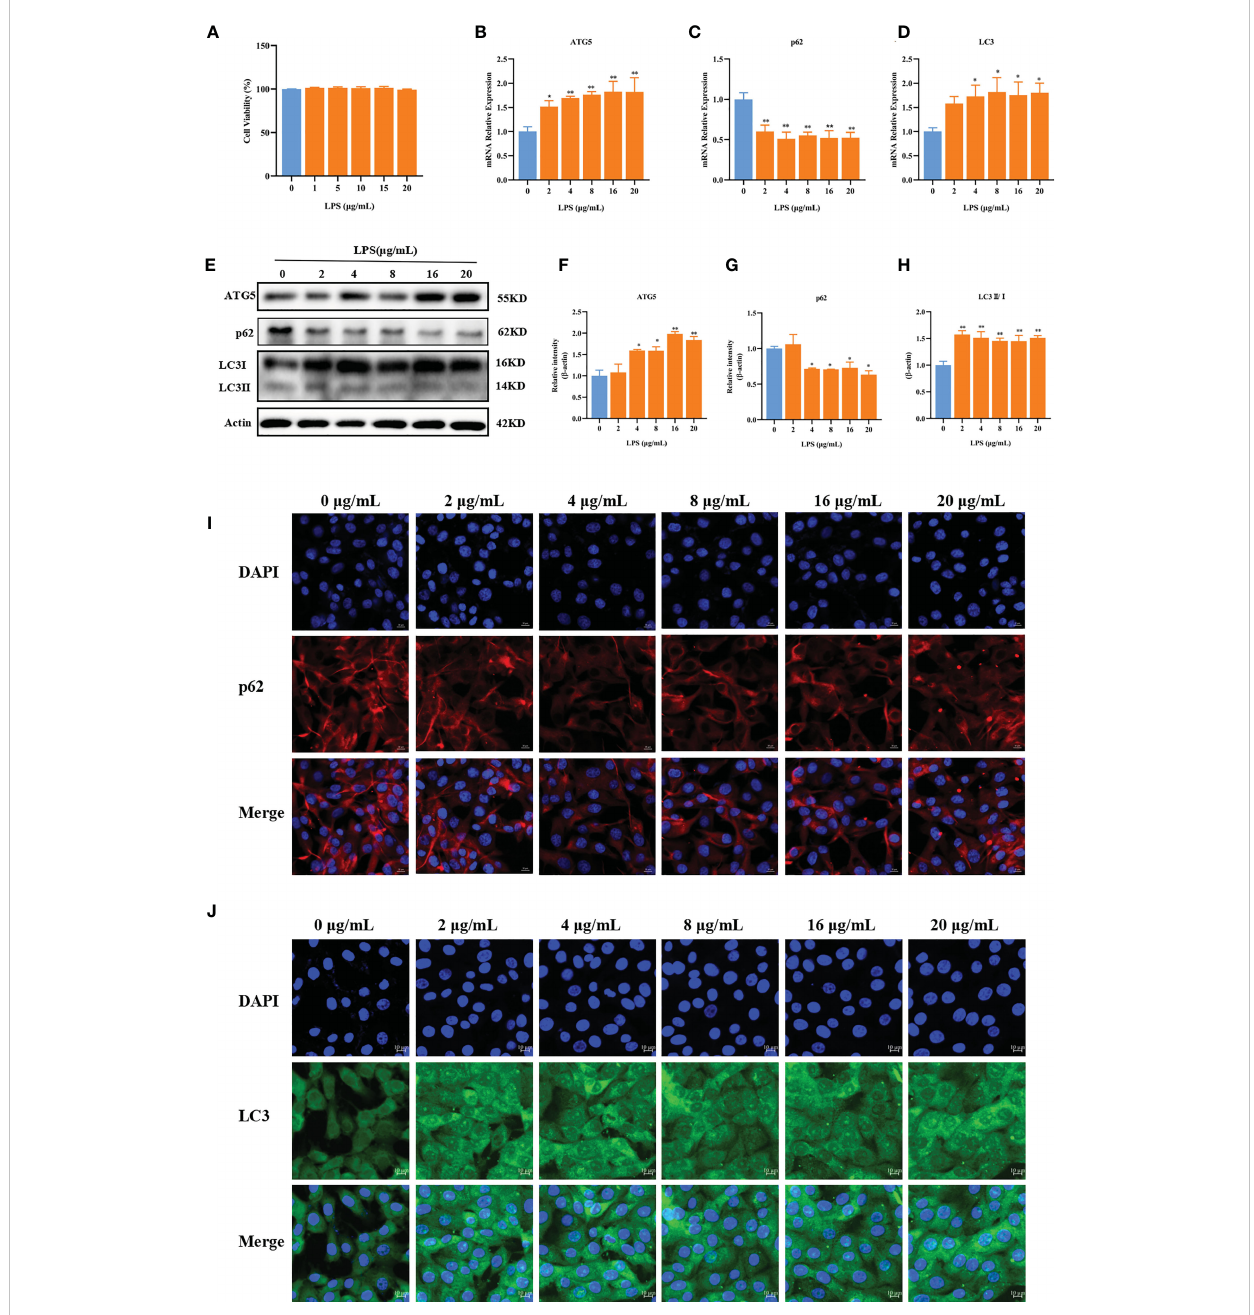
FIGURE 4 LPS can induce autophagy. Effects of LPS on the cell viability of BMECs (A) . Effects of different concentrations of LPS on the mRNA expression of p62, ATG5, and LC3 in BMECs for 3 h (B – D) . Effects of different concentrations of LPS on the protein expression of p62, ATG5, and LC3II/I in BMECs for 3 h (E – H) . Immuno fl uorescence results of p62 and LC3 in BMECs treated with different concentration LPS in BMECs for 3 h (I, J) . Scale bar, 10 m m. * p < 0.05, ** p < 0.01, representing signi fi cant difference compared with the Ctrl